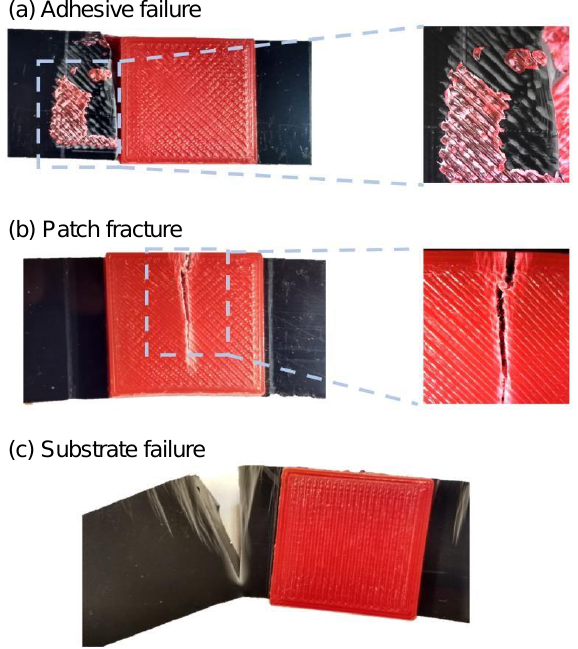
Figure 12. Failure modes ( a ) between the patch and the substrate, ( b ) within the patch, and ( c ) within the substrate.